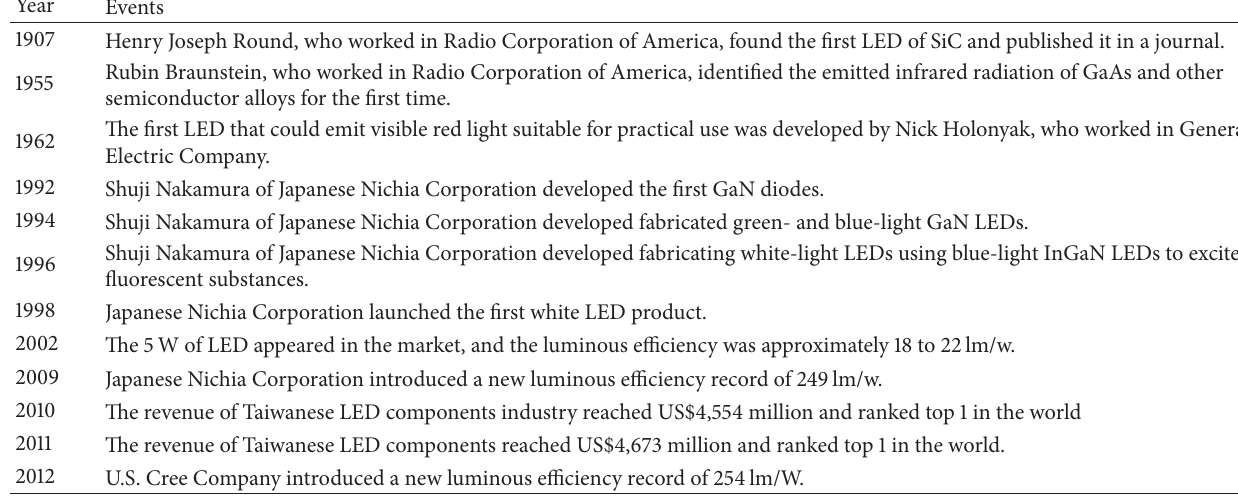
Table 1: The history of global LED industry.